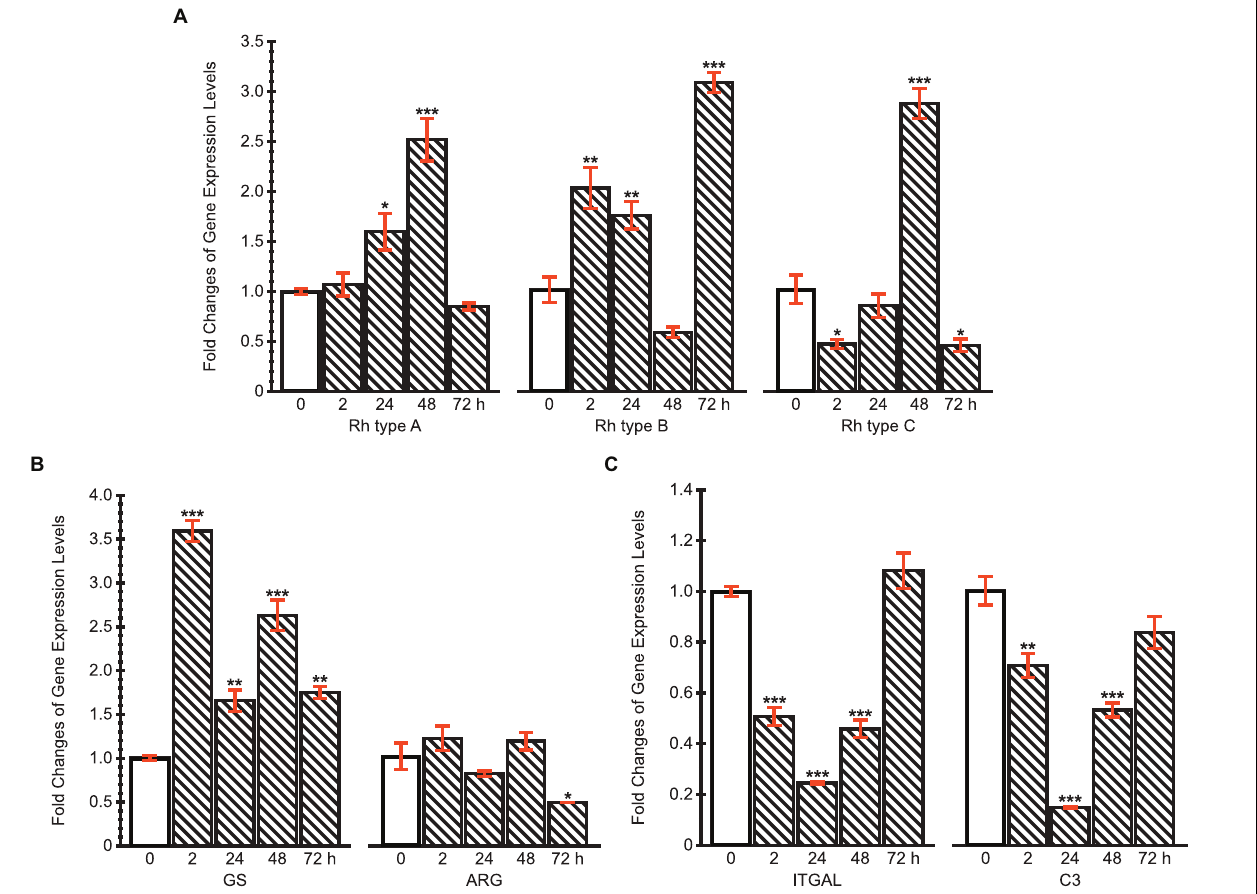
FIGURE 7 | Fold changes of expression levels of (A) Rh type A-C genes; (B) GS and ARG genes; (C) ITGAL and C3 genes under ammonia challenge (10 mg.L − 1 ). Values are shown as mean ± standard error of the mean (S.E.M). Asterisks (*) above the bars denote significant difference between the control (0 h) (blank pattern) and ammonia challenged groups (line pattern) (* P < 0.05, ** P < 0.01, *** P <